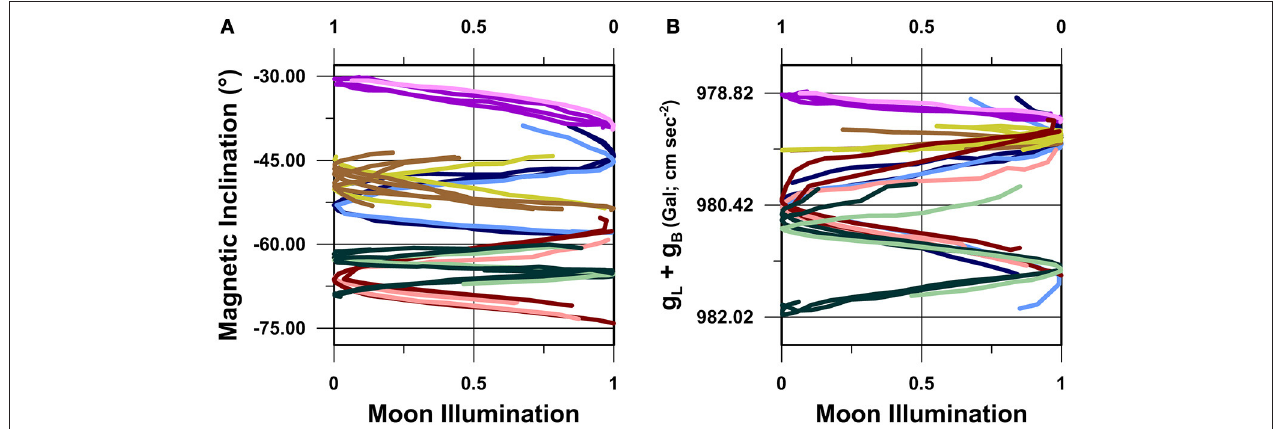
FIGURE 7 | Cross-taxa compilation of route fidelity movement trajectories in (A) magnetic inclination vs. moon illumination, and (B) g L + g B vs. moon illumination, bivariate spatiotemporal coordinate spaces. Lines in (A) colored as in Figure 5 . Lines in (B) colored as in Figure 6 .